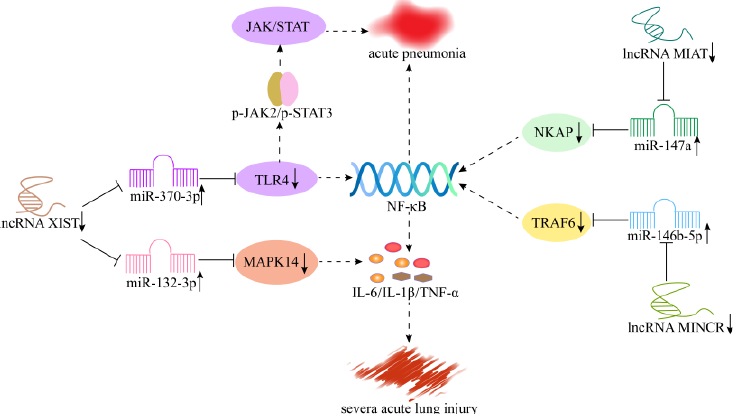
Figure 6. Mechanism of lncRNAs in lung inflammatory injury. Knockdown of lncRNA XIST regulates the JAK/STAT3 and NF- κ B signaling pathways by targeting miR-370-3p/TLR4, thereby inhibiting acute pneumonia. Knockdown of lncRNA XIST alleviates acute lung injury by regulating the miR-132-3p/MAPK14 pathway. Downregulation of lncRNA MINCR regulates the TRAF6 expression levels by targeting miR-146b-5p, thereby inhibiting NF- κ B activation and attenuating ALI. Low expression of lncRNA MIAT inhibits the activation of NF- κ B pathway by targeting miR-147a/NKAP axis, thereby alleviating the damage of pneumonia.